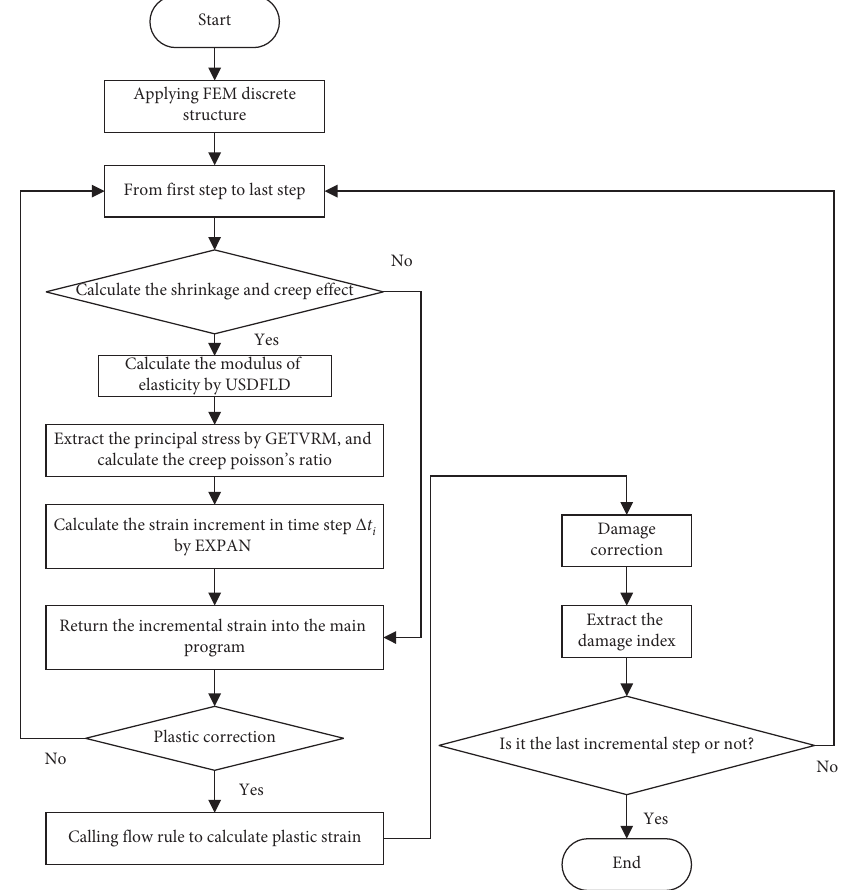
Figure 4: Computation program flowchart of the creep and shrinkage